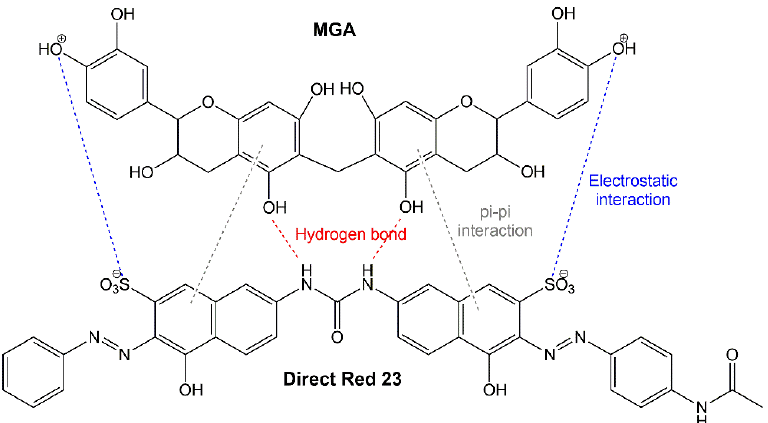
Figure 7. Mechanism of direct red 23 adsorption to modified gambir adsorbent (MGA).